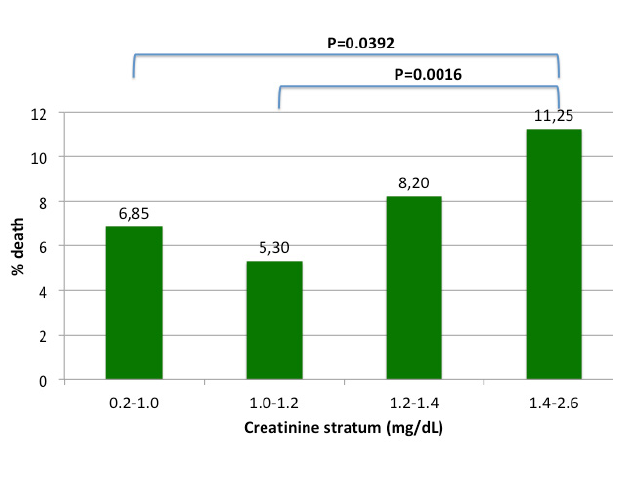
Fig. 1 - Inter-stratum